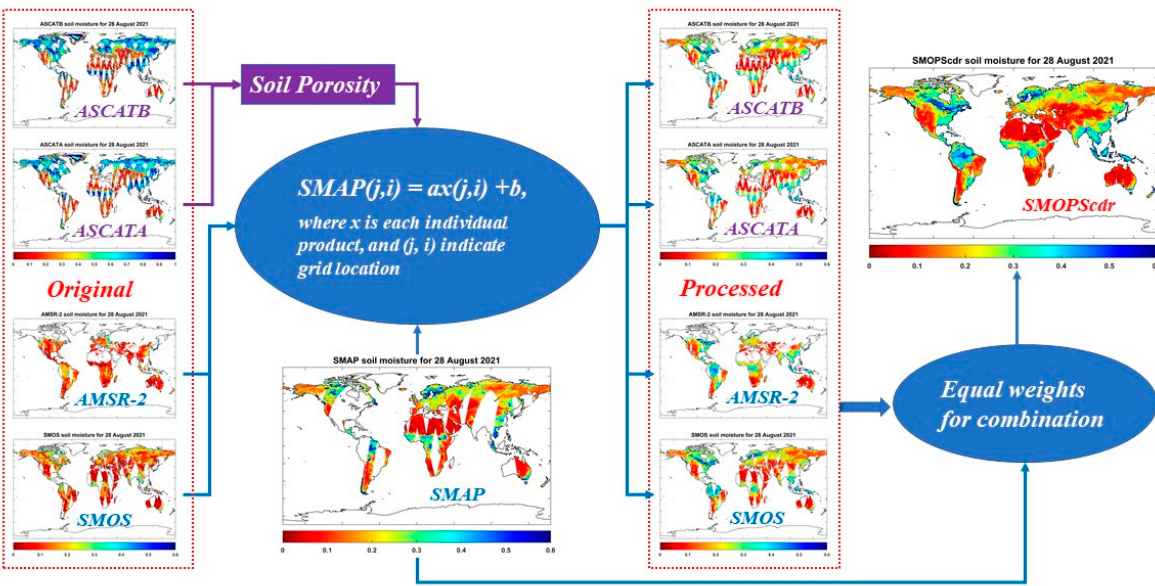
Figure 1. Process procedure of generating the 0.25° blended SMOPScdr soil moisture data product using ASCATA, ASCATB, SMOS, SMAP and AMSR-2 SM retrievals. Table 2. With respect to the SMAPVAL soil moisture observations, statistics for studying domain- averaged RMSE, ubRMSE and correlation coefficients ( r ), as well as the corresponding statistical periods for the original individual satellite retrievals and the developed SMOPScdr data